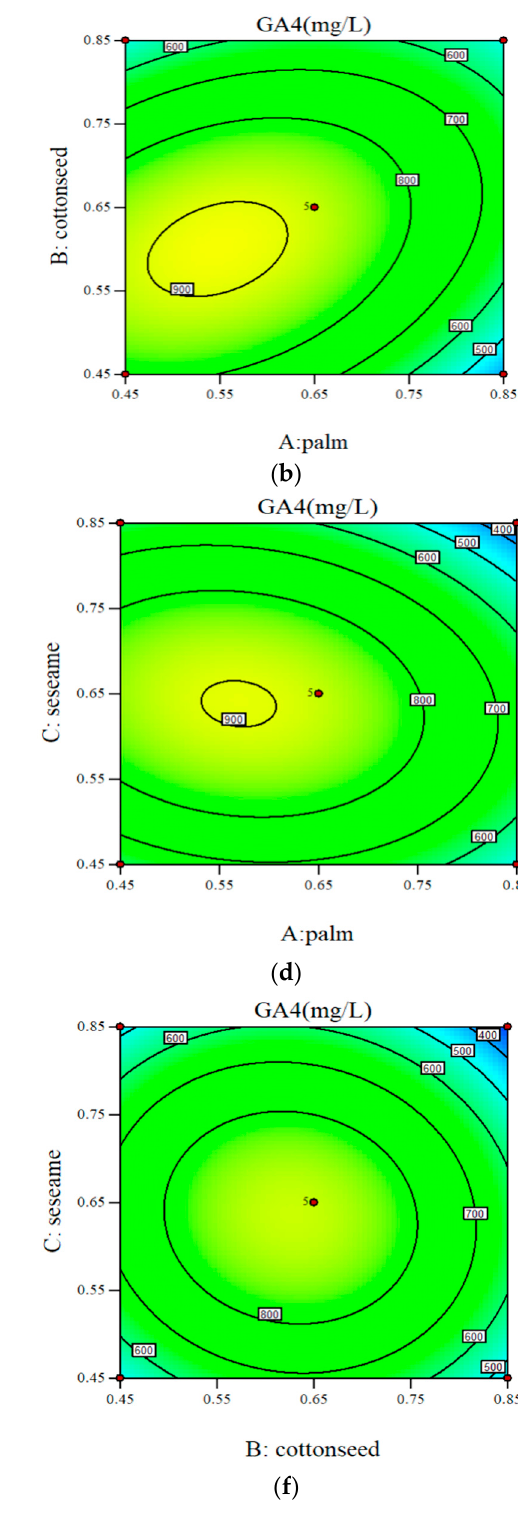
Figure 3. Three ‐ dimensional response surface plots and corresponding two ‐ dimensional contour Figure 3. Three-dimensional response surface plots and corresponding two-dimensional contour plot plot showing the effects of variables and interaction with GA4 production. Three ‐ dimensional re ‐ showing the effects of variables and interaction with GA4 production. Three-dimensional response surface interaction plots of palm and cottonseed oil ( a ), palm and sesame oil ( c ), and cottonseed and sesame oil ( e ). Corresponding two-dimensional contour plot interaction of palm and cottonseed oil ( b ), palm and sesame oil ( d ), and cottonseed and sesame oil ( f